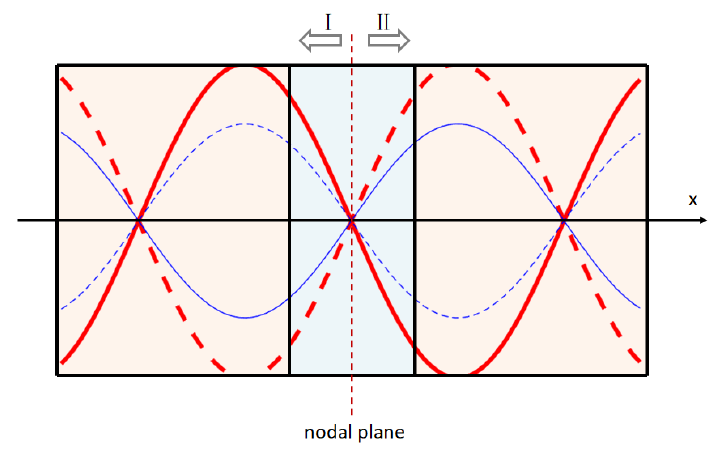
Figure 2. Waveform diagram of nodal plane.